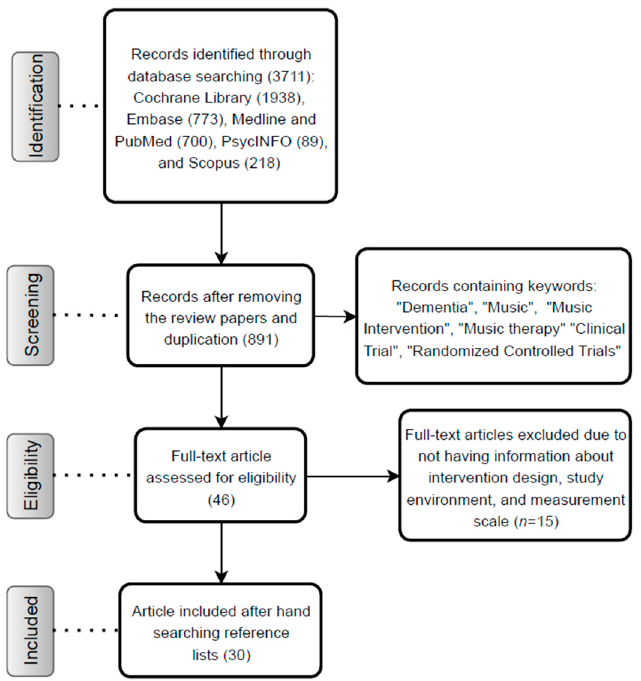
Figure 3. Flow diagram of this review study.